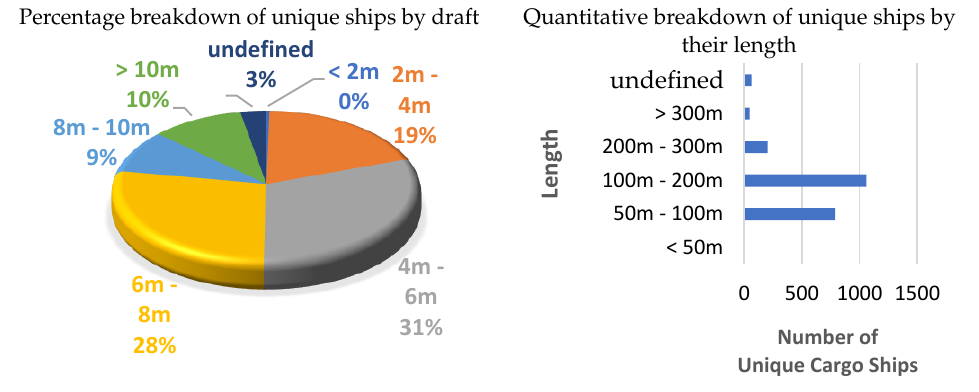
Table 7. Qualitative characteristics of cargo vessels.